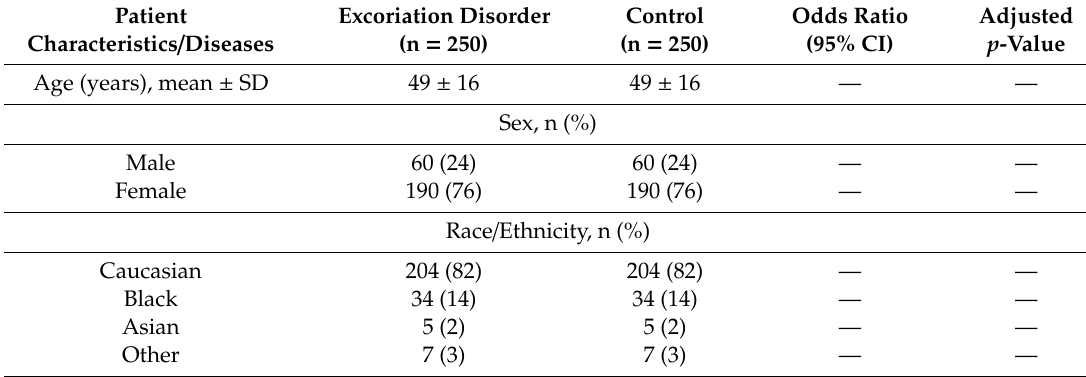
Table 2. Demographics and case-control analysis of the comorbidities of ED patients and age-, race-, and sex-matched